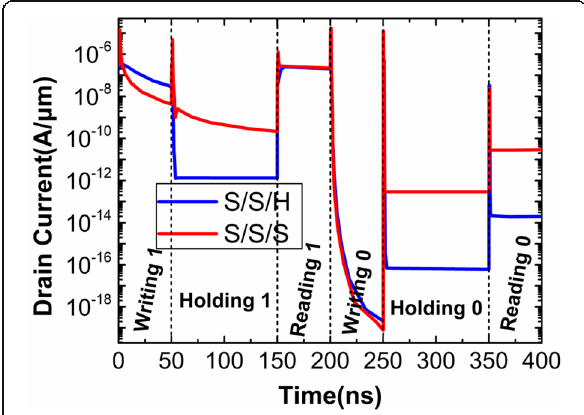
Fig. 7 Transient responses of drain currents for S/S/H and S/S/S operated in Table